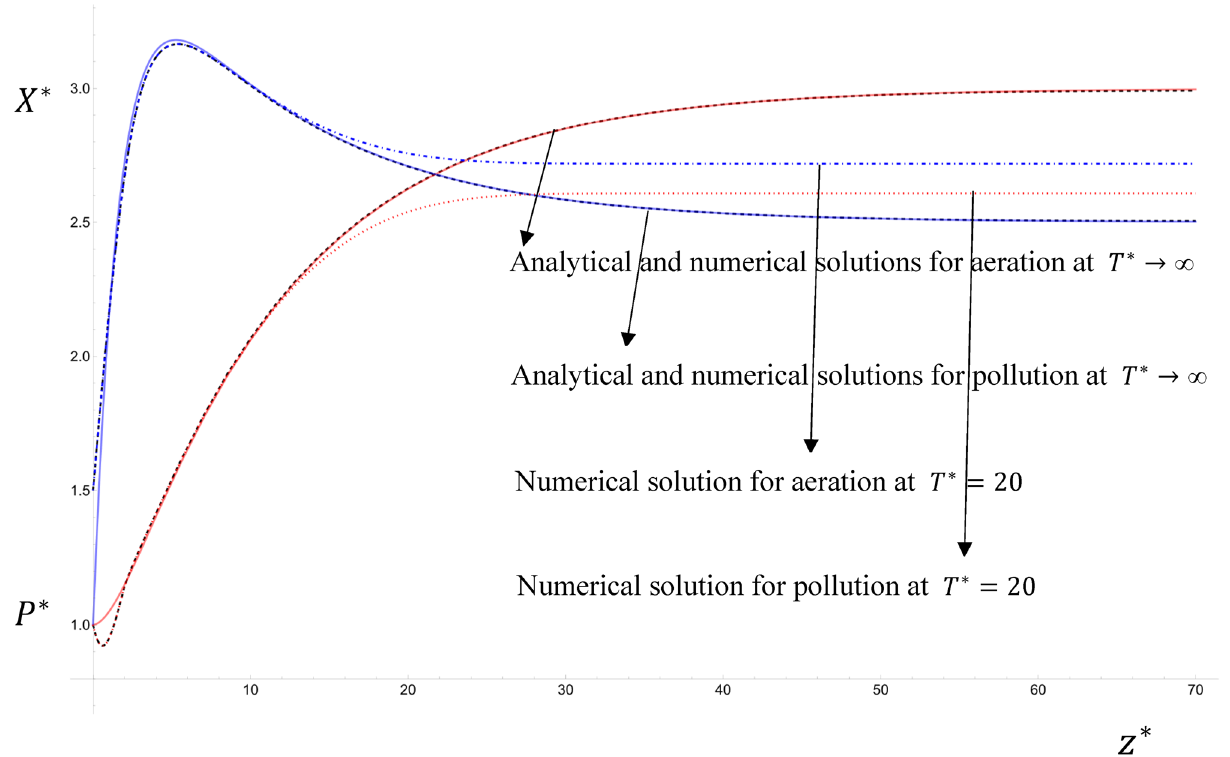
Figure 4. The comparison between the steady state analytical solutions given by Eqs. (28, 29) and the steady state of the numerical solution of Eqs. (30, 31).